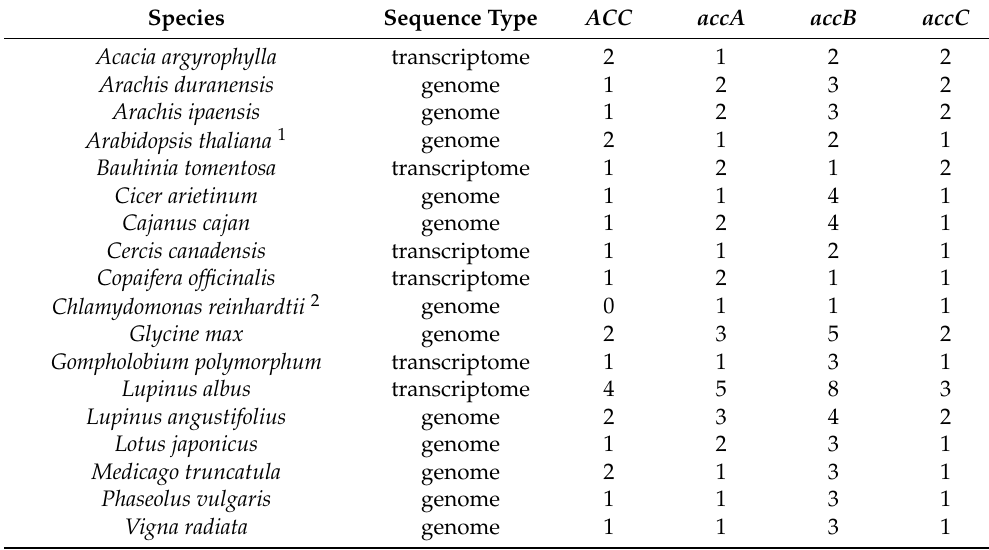
Table 5. Number of predicted ACCase